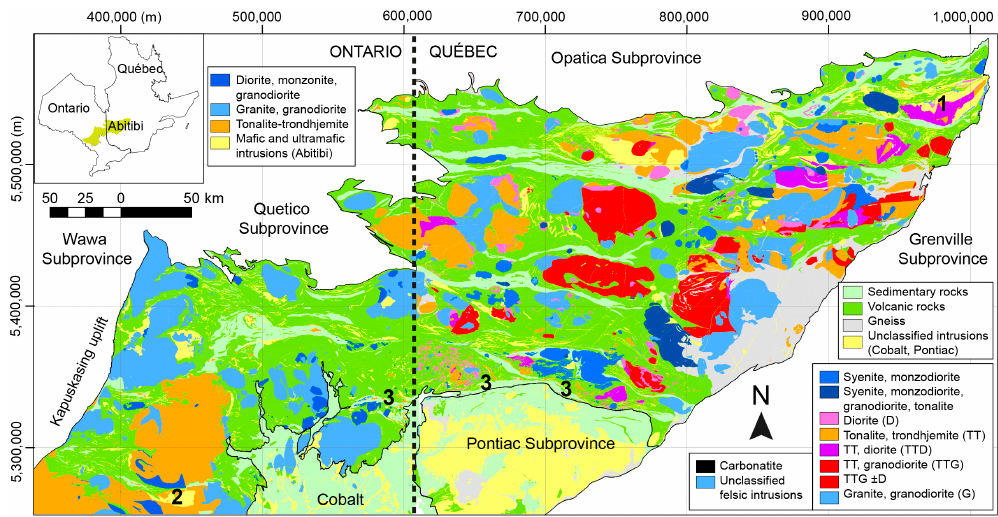
Figure 1. Geological map of the Abitibi Subprovince showing the distribution of the main lithologies as classified for the need of this study (see text for details). The map is modified from the Ministère de l’Énergie et des Ressources Naturelles of Québec (MERN), Sigeom dataset, and the Ontario Geological Survey (OGS). The projection is UTM NAD83 Zone 17N. Numbers locate the Chibougamau (1) and Chester (2) plutons, as well as the gold-endowed Cadillac-Larder Lake fault zone (3). The Central Camp Cu-Au and Côté-Gold Au-(Cu) mineralization raise the question of the importance of TTG versus TTD suites in the evolution of greenstone belts and their magmatic- hydrothermal systems and related mineralization. This contribution uses the Abitibi Subprovince as an example to discuss the chemistry of tonalite-dominated magmatism in the context of greenstone belts. The relative abundance and distribution of diorite, tonalite, and granodiorite are also evaluated, and the importance of these parameters for the prospectivity of fertile magmatic-hydrothermal